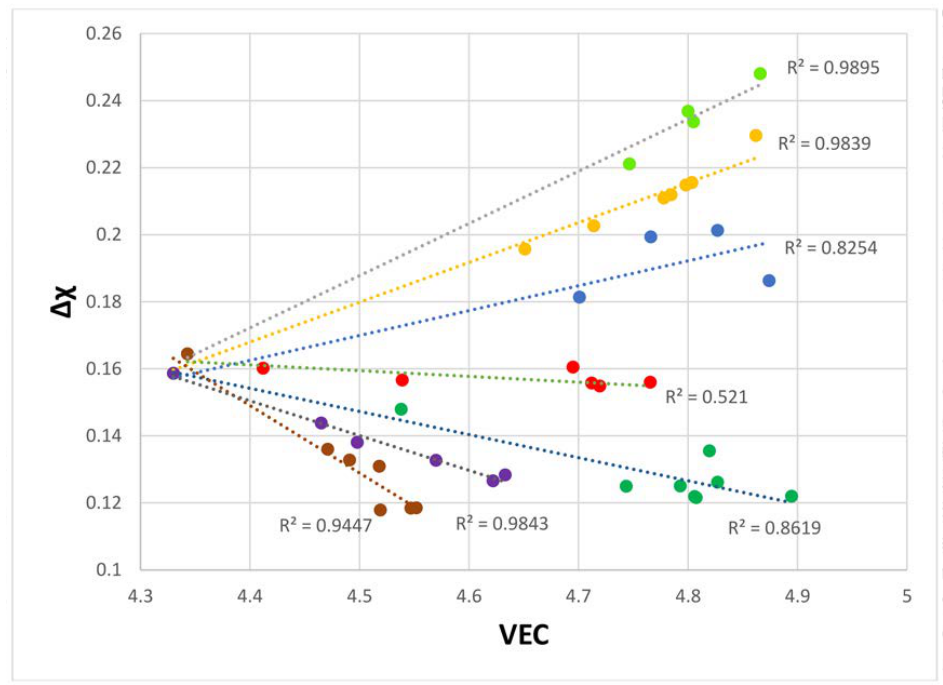
Figure 5. ∆ χ versus VEC of eutectics with Nb ss and Nb 5 Si 3 in Nb-silicide based alloys. Series a (R 2 = 0.9447) with alloying element additions of Al, Cr, Ge, Hf, Si, Sn, Ti, and Y; series b (R 2 = 0.9843) with alloying element additions of Al, Cr, Fe, Ge, Si, Sn, and Ti; series c (R 2 = 0.8254) with alloying element additions of Al, Cr, Ge, Hf, Mo, Si, Sn, Ta, Ti, V, W, and Zr; series d (R 2 = 0.9893) with alloying element additions of Al, Cr, Ge, Hf, Mo, Si, Sn, Ta, Ti, V, and W; series e (R 2 = 0.9895) with alloying element additions of Al, Cr, Ge, Hf, Mo, Si, Sn, Ti, and W; series f (R 2 = 0.5210) with alloying element additions of Al, Cr, Hf, Mo, Si, Sn, Ta, Ti, and V; series g (R 2 = 0.8619) with alloying element additions of Al, Cr, Fe, Ge, Hf, Si, Sn, and